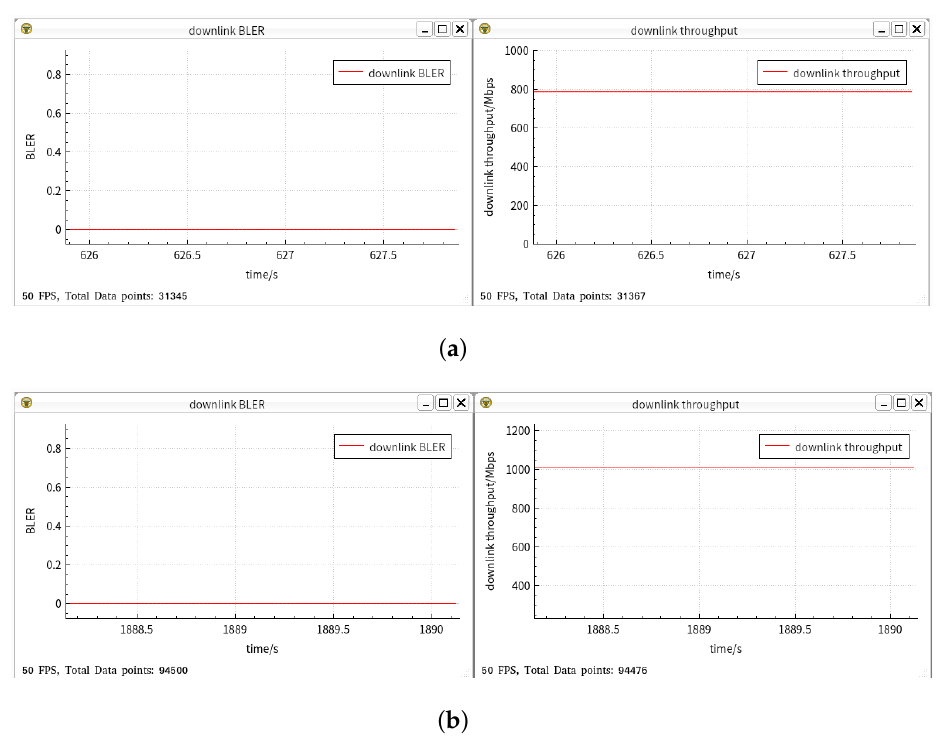
Figure 13. The BLER and throughput results of our example testbed. ( a ) The BLER and throughput results under 16-QAM modulation; ( b ) The BLER and throughput results under 64-QAM